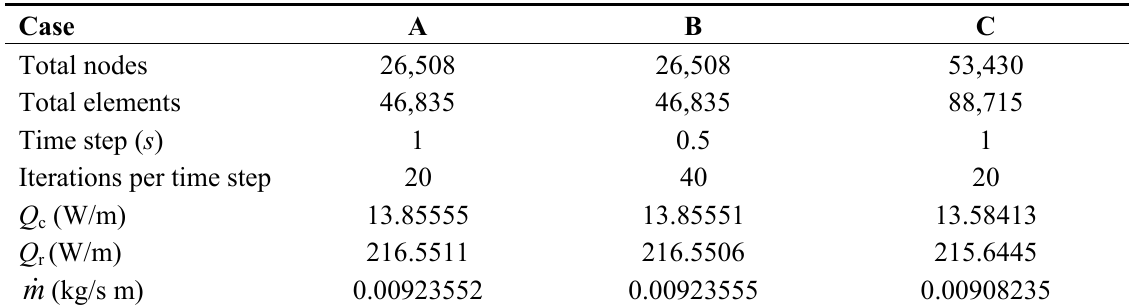
Table 1. Summary of grid and time-step dependence tests for a 5/12 attic with R-20 ceiling insulation.